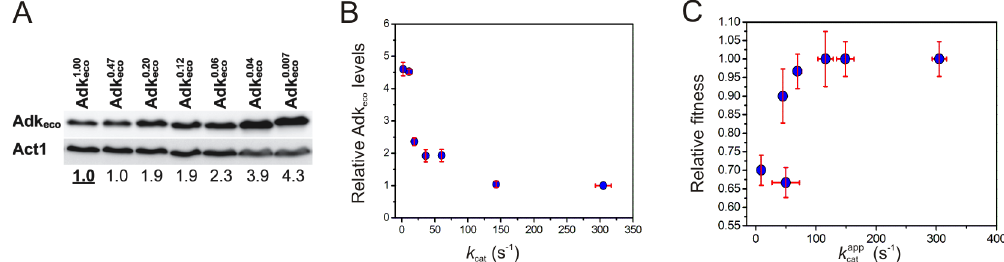
Fig 9. Effect of Adk eco expression levels in yeast cells. (A) Western blot analysis of Adk eco proteins expressed from the pRS315 vector in adk1 Δ yeast cells and detected by a rabbit polyclonal anti-Adk eco antibody. Endogenous Act1p was used as a loading control. Protein levels of the Adk eco variants were normalized with respect to wild-type Adk 1 : 00 protein levels (Table 2). (B) Increases in Adk eco protein levels correlate with reductions in catalytic activity eco ( i . e k cat normalized with respect to Adk eco protein levels according to Eq ( k cat ). (C) Relative fi tness plotted versus k app cat 2). Cells were cultivated at 20°C for western blots. Error bars for protein levels indicate standard deviations obtained from three independent biological